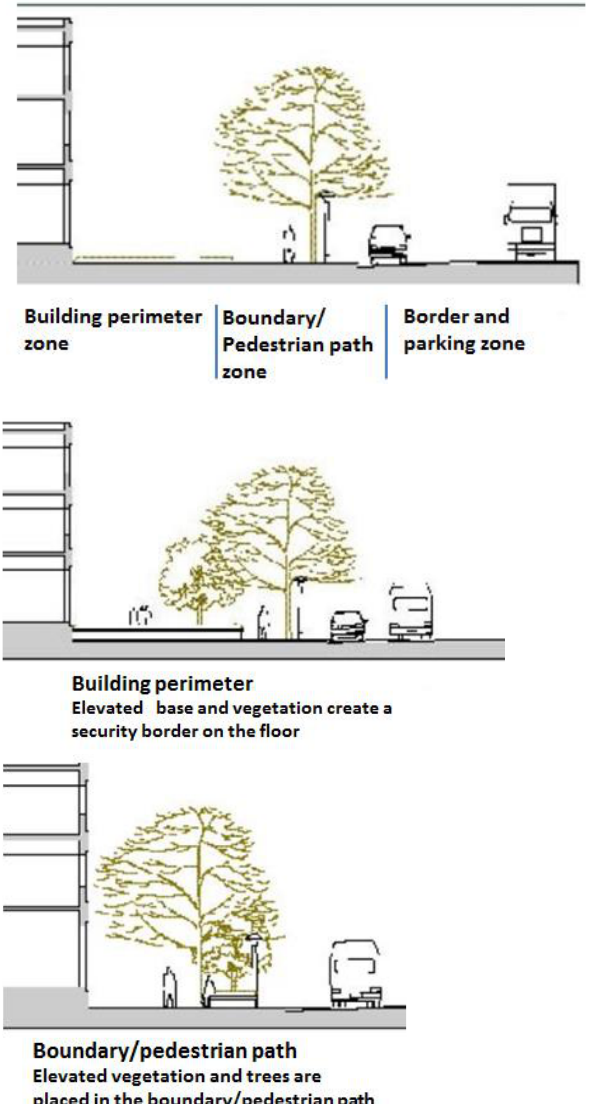
Figure 3. Up: security zones (National Capital Authority, 2003, p.7); middlel: building perimeter zone; down: border/pedestrian zone (National Capital Authority, 2003, p.9).